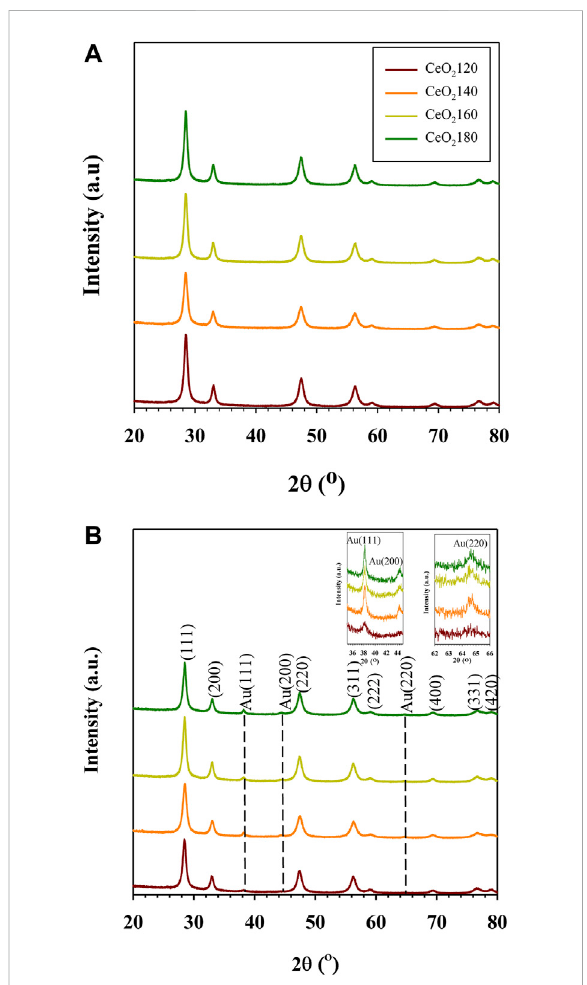
FIGURE 2 Representative wide-angle X-ray diffraction patterns of (A) the synthesized CeO 2 X support and (B) the prepared Au/CeO 2 X catalysts. The reported diffractograms are representative of those obtained from two independent samples. CeO 2 X: cerium oxide obtained at a value X for the temperature of the preparatory hydrothermal process; Au/CeO 2 X: CeO 2 X-supported gold